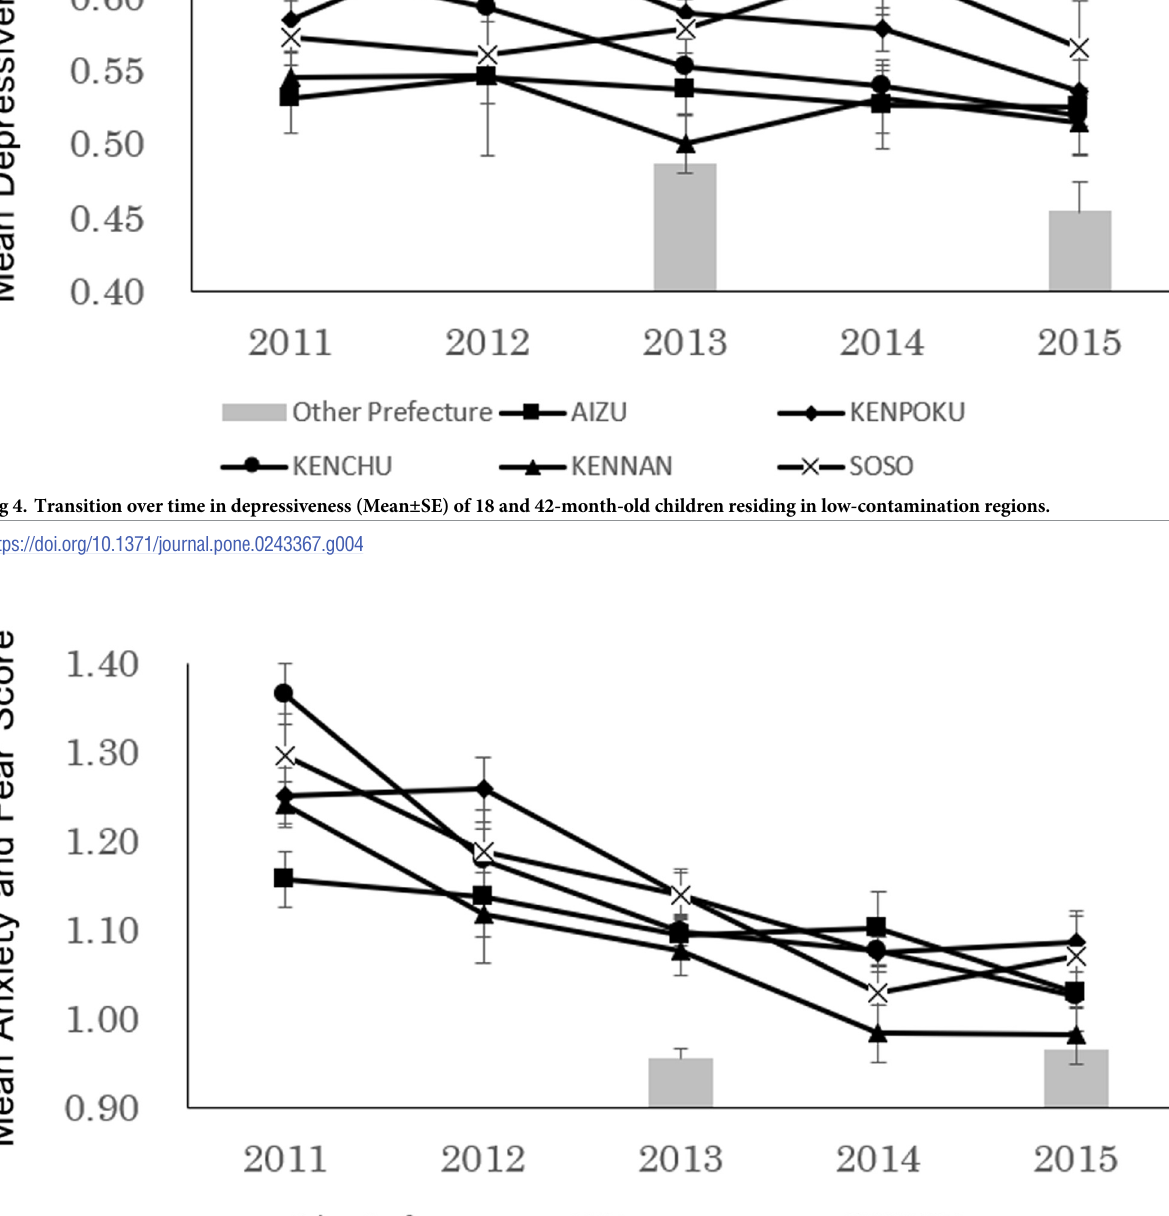
PLOS ONE | https://doi.org/10.1371/journal.pone.0243367 December30,